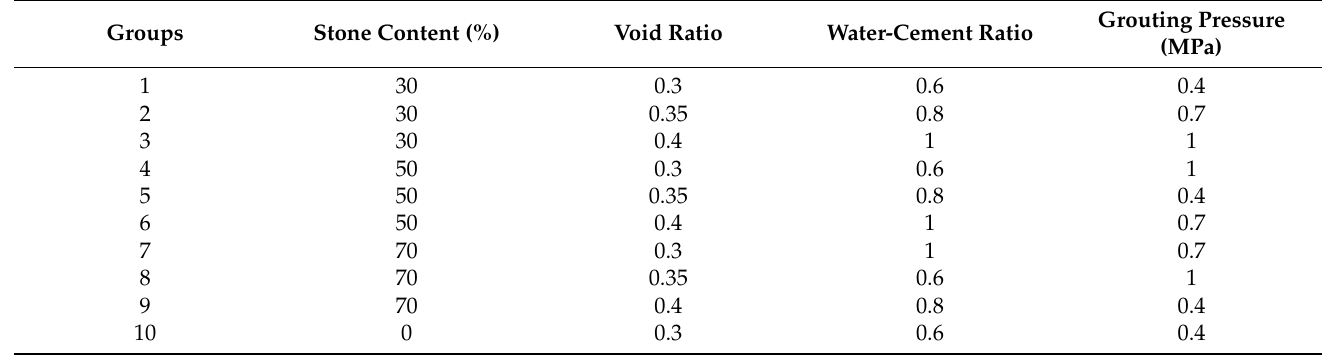
Table 1. Orthogonal test table of the grouting